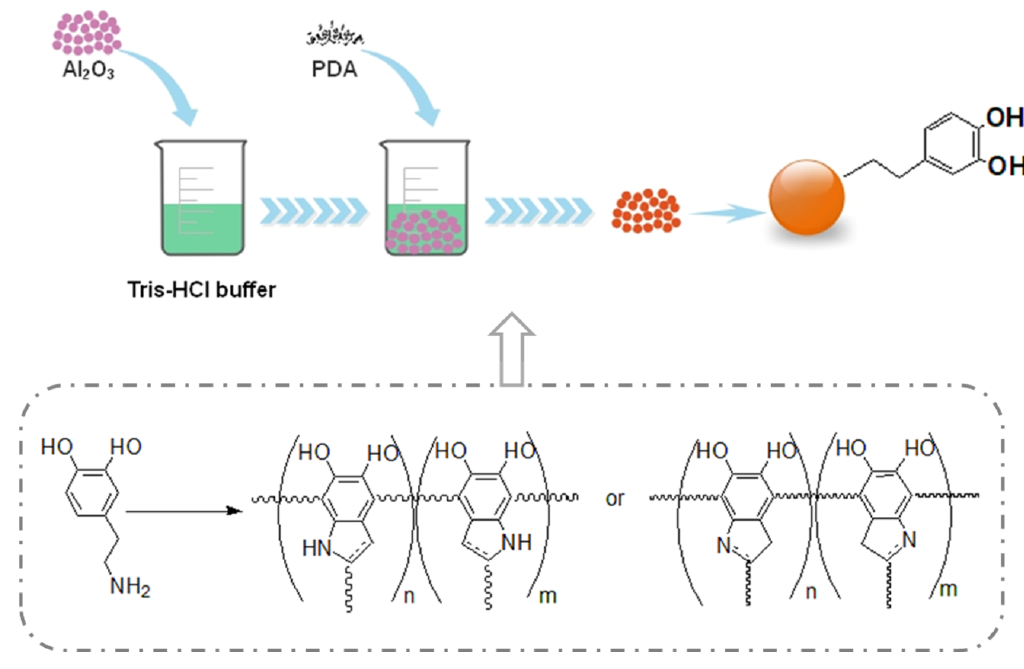
Figure 2. Scheme of modification of pristine Al 2 O 3 surface using polydopamine (PDA).